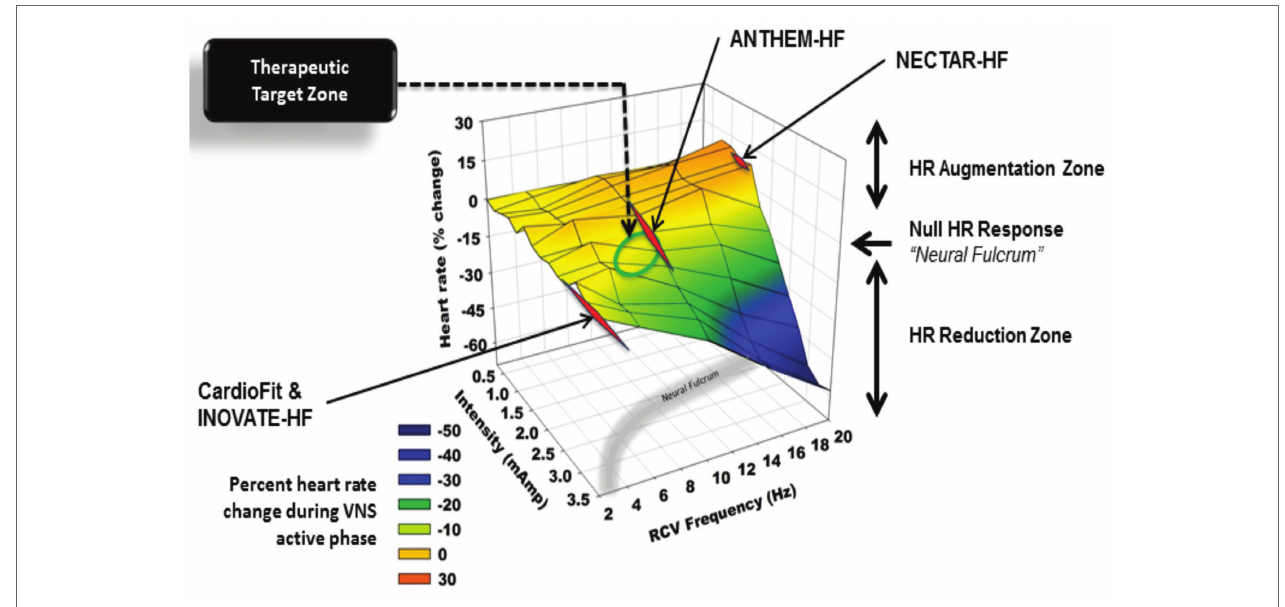
FIGURE 11 | Heart rate responses to right cervical vagus nerve stimulation in a canine model at varying frequency and intensity (pulse width 500 μ s). At higher frequencies and current, vagal nerve stimulation results in predominant activation of vagomotor efferent fibers, producing a bradycardia (blue). At higher frequencies and lower current, vagal nerve stimulation results in a relative tachycardia due to preferential activation of afferent fibers (orange, red). The area at which a null heart rate response is achieved is the neural fulcrum (yellow surface). Achieved stimulation parameters for three vagus nerve stimulation trials (ANTHEM-HF, NECTAR-HF, and INOVATE-HF) are plotted as a function of frequency and intensity. Adapted from Ardell et al. (2017) with